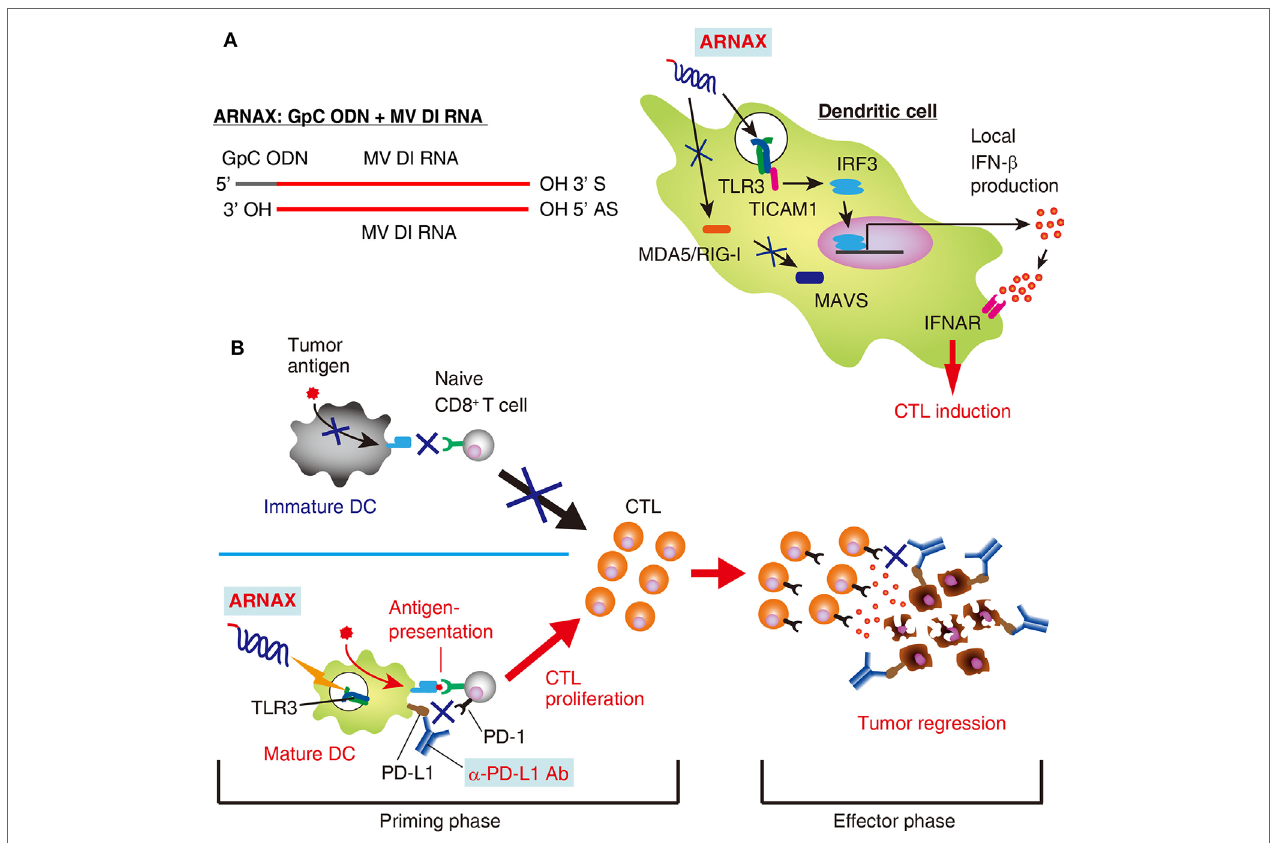
FiGURe 1 | Structure and function of ARNAX. (A) Structure and signaling pathway of ARNAX. ARNAX activates endosomal toll-like receptor 3 (TLR3), but not cytoplasmic MDA5/RIG-I. The TLR3–TICAM-1–IRF3–IFN- β signaling axis is indispensable in dendritic cells (DCs) for ARNAX-mediated cytotoxic T lymphocyte